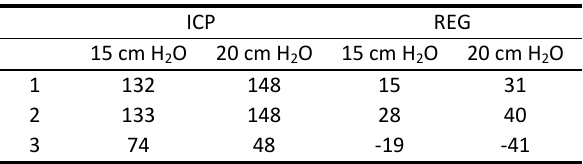
Figure 13. Intracranial pressure (ICP), systemic arterial pressure (SAP), REG integral (REG integral), PRx, and REGx plotted as analog strip chart vs. time. The first number of PRx and REGx calculations starts at 300 sec of the original signal. Pig CBF 9, file 13:32; time window 96.52 min. Table 2. Percent changes of mean ICP and REG integral during 15 and 20 cmH 2 O PEEPs before first (1) and after first bleedings (2), and after second bleeding (3). Values are in percentage of their own baseline. Measurement was made at the highest values. Note that after 2 nd bleeding REG values are negative, indicating that CBF AR is